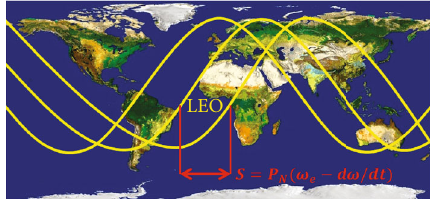
Figure 6: The footprints of one LEO